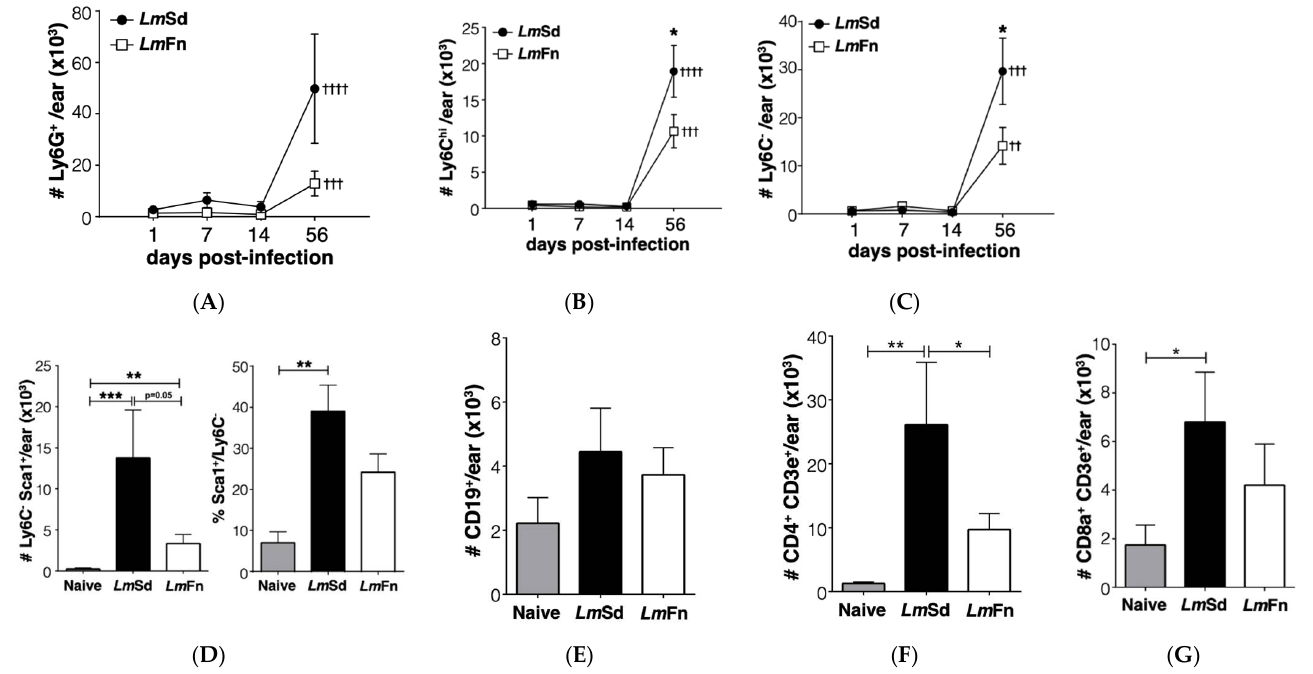
Figure 2. Myeloid cell accumulation at the site of infection in cutaneous leishmaniasis. Populations of myeloid (CD11b + ) cells were defined by the following markers: ( A ) Ly6G + granulocytes; ( B ) Ly6C hi Ly6G − inflammatory monocytes; and ( C ) Ly6C − Ly6G − resident dermal macrophages and monocyte-derived myeloid cells. ( D ) Number and percentage of Ly6C − Ly6G − MHC-II + cells that express Sca-1 antigen on day 56 post-infection. ( E ) CD19 + B lymphocytes, ( F ) CD4 + and ( G ) CD8 + T lymphocytes detected on day 56 post-infection. Graphs represent compiled results (mean ± SEM) from at least 4 independent experiments for each time point, with n = 9, n = 7, n = 7 and n = 15 mice per group ( Lm Fn vs. Lm Sd) at 1-, 7-, 14-, and 56-days post-infection, respectively. *, **, *** p < 0.05 comparing infection with Lm Fn vs. Lm Sd at a given time point and ††, †††, †††† p < 0.05 comparing infected groups ( Lm Fn or Lm Sd) to naïve control mice. See also Supplementary Figure S1 for flow cytometry gating strategies and representative results.